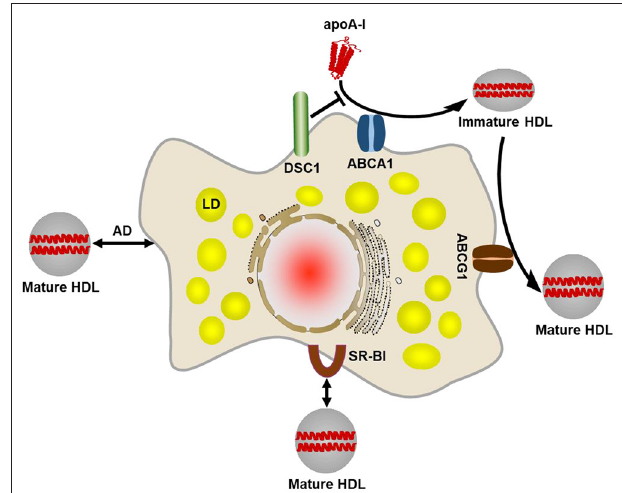
FIGURE 1 | Four main cholesterol efflux pathways in macrophages. The ABCA1-mediated cholesterol efflux pathway plays the primary role in removing excess cholesterol from macrophages. ABCA1 creates a plasma membrane microdomain to facilitate efflux of phospholipids and cholesterol to lipid-free or lipid-poor apolipoproteins such as apoA-I. An apoA-I binding protein DSC1 sequesters apoA-I and prevents the lipidation of apoA-I by ABCA1. The lipidated apoA-I is called a nascent HDL particle. The nascent, immature HDL acquires additional cholesterol via the ABCG1-mediated efflux pathway so as to form a mature HDL particle. It seems likely that ABCG1 function is to increase the pool of cholesterol available for efflux. Mature HDL particles bind to SR-BI on the cell surface, which facilitates diffusion of cholesterol molecules between the plasma membrane and the HDL particle bound. The extracellular domain of SR-BI forms a non-polar channel to mediate the cholesterol exchange. Mature HDL particles are also capable of acquiring cholesterol via aqueous diffusion (AD). AD is a simple diffusion process in which cholesterol molecules desorb from the plasma membrane or HDL particles, move down its concentration gradient in the extracellular aqueous space, and incorporate into the plasma membrane or HDL particles. LD, lipid droplet.